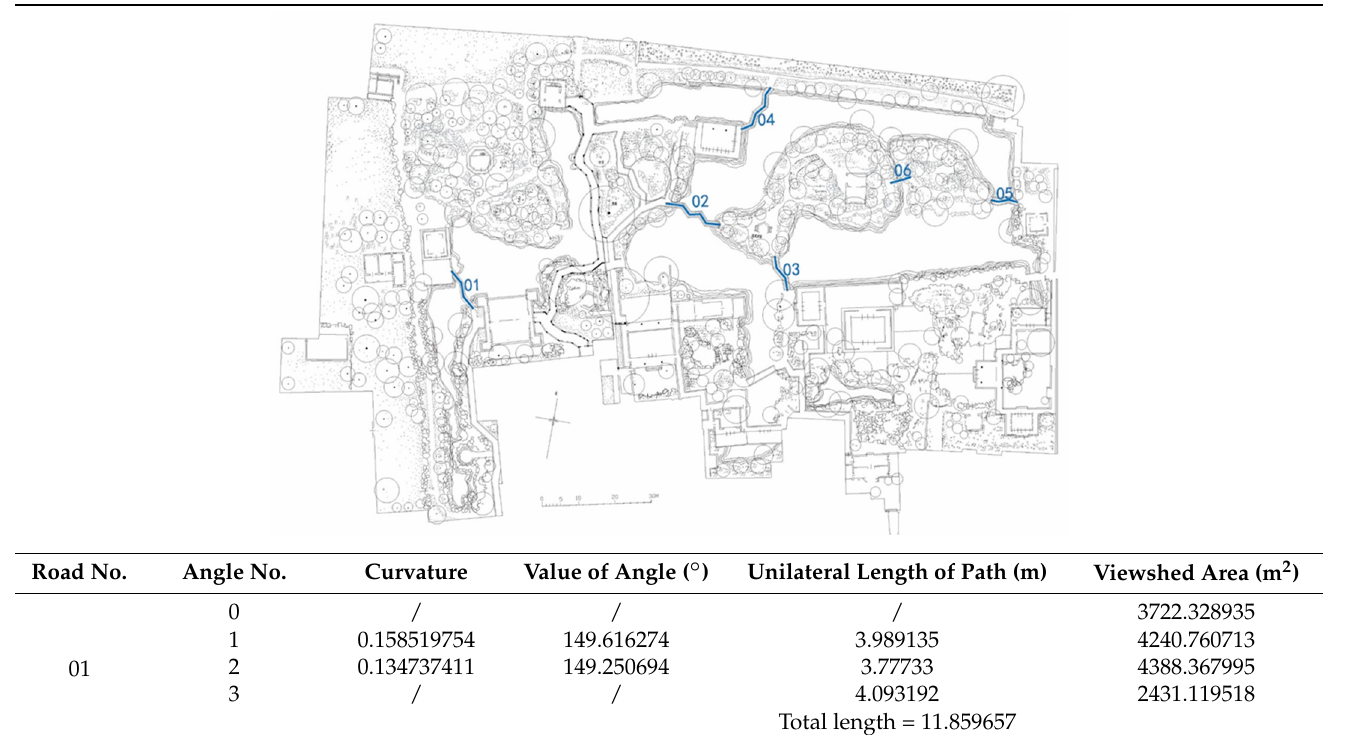
Table A20. Humble Administrator’s Garden, bridge.